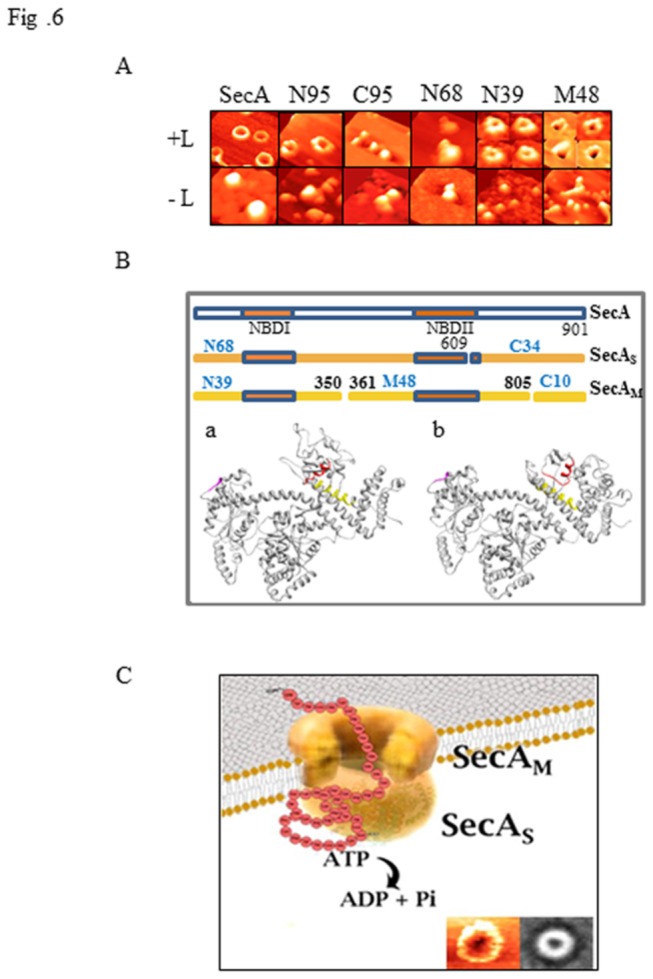
AFM images of SecA and its domains suggesting a model of a SecA channel for protein secretion.(A) Structural variations adopted by purified SecA and a series of its truncated domains were determined by incubating them in the presence and absence of lipid bilayers (+/- L) prepared from E. coli extracted lipid mixtures. Sheets of mica were freshly cleaved and samples were prepared as previously described [14]. The upper rights images are a series of zoomed-in images of N39 and M48 incubated in the presence of liposomes and, are not shown to scale. The estimated sizes for SecA, N39 and M48 are 10.3 ± 1.0 nm, 7.1 ± 0.4 nm and 6.2 ± 0.4 nm, respectively, with n>15. (B) Potential trypsin cleavage sites of N68, and N39 and M48, in SecA are shown along with the location of the two nucleotide binding sites, each with its own attendant Walker A and B motifs (orange bars). The location of each of the potential cleavage sites in the crystal lattice structure of SecA in either the open-state (a) or in the closed-state (b) are also shown. The potential cleavage-site 1 (609-613) is colored in magenta, while the cleavage-site forming the N39 region is colored in red and the cleavage-site separating M48 from C10 is colored in yellow. (C) A model as to how the asymmetric dimer of SecA forms a functional channel that allows protein precursors to be translocated across the cytoplasmic membrane and into the periplasm. The two distinct forms of integral SecA (SecAM and SecAS) together form the structural channel that can be observed for SecA alone using AFM and TEM (lower right frames). SecAM consists of N39, M48 and C10, and SecAS, consists of N68 with ATPase activity and C34, and appears to adopt the same conformation as SecA in its fully soluble form.